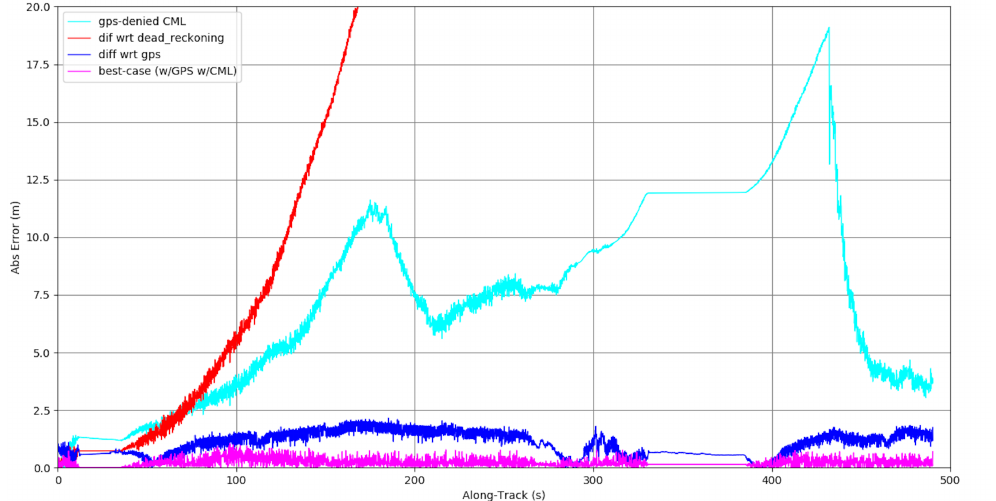
Figure 10. Costmap-Based Localization (CBL) on a static Persistent Map (part b). This graph shows the absolute error between several different Kalman-filter based localizations including state-of-the- art best case scenario (GPS, wheel encoders, and inertial measurements) in blue, dead reckoning (wheel encoders and inertial measurements) in red, and costmap based localization (CML, wheel encoders, and inertial measurements), in magenta with access to GPS or cyan without access to GPS, on the course shown in Figure